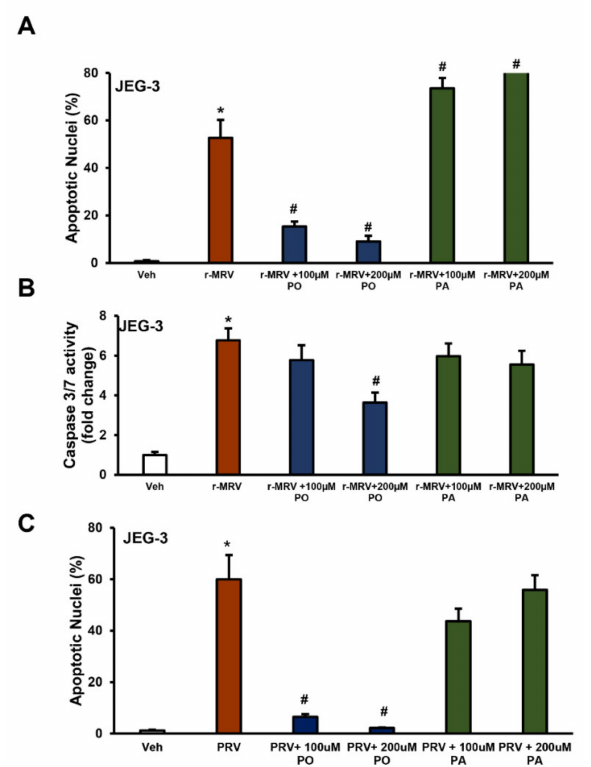
Figure 4. Palmitoleate protects against ZIKV-induced apoptosis but not palmitate. ( A , B ) There was significant reduction in ( A ) percentage apoptotic nuclei and ( B ) caspase 3/7 activation in JEG-3 cells treated with palmitoleate 48 hpi with 0.1 r-MRV suggesting the protective role of palmitoleate against ZIKV-induced apoptosis. When the JEG-3 cells were treated with palmitic acid 48 hpi, there was significant increase in the percent apoptotic nuclei and a trend towards increase in caspase 3/7 activation, suggesting that palmitate did not protect against ZIKV-induced apoptosis. Data represent mean ± SEM, n = 3 for percentage apoptotic nuclei and n = 4 for caspase 3/7 activity. * p < 0.05 compared to uninfected vehicles cells, # p < 0.05 compared to ZIKV-infected cells. ( C ) Similarly, in JEG-3 cells with 1.0 MOI of PRV for 48 h the percent apoptotic nuclei significantly reduced in 100–200 µ M palmitoleate treated PRV-infected cells compared to PRV-infected cells alone; however, treatment of palmitate to ZIKV-infected cells did not prevent ZIKV-induced apoptosis. Data represent mean ± SEM, n = 3. * p < 0.05 compared to uninfected vehicles cells, # p < 0.05 compared to ZIKV- infected